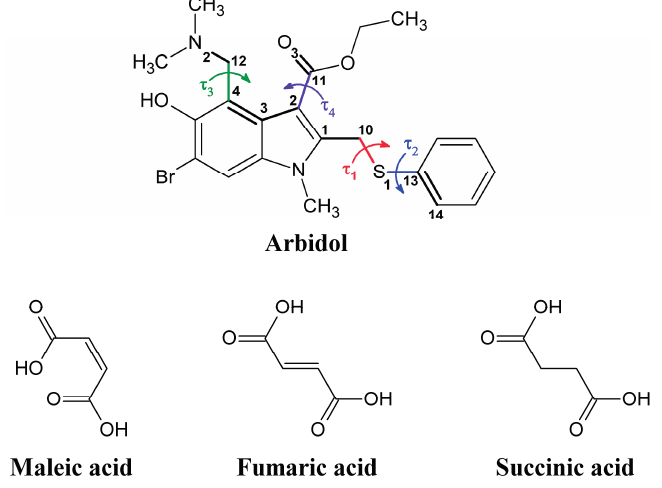
Figure 1. Molecular structures of arbidol, maleic, fumaric and succinic acids used in this work. The flexible torsion angles in the arbidol molecule are numbered and are indicated by τ 1 , τ 2 , τ 3 and τ 4